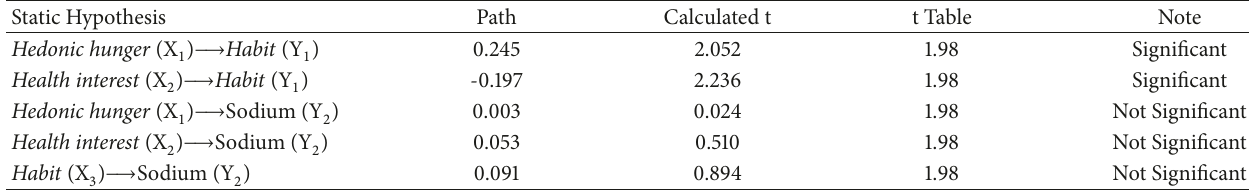
Table 5: Hypothesis Testing